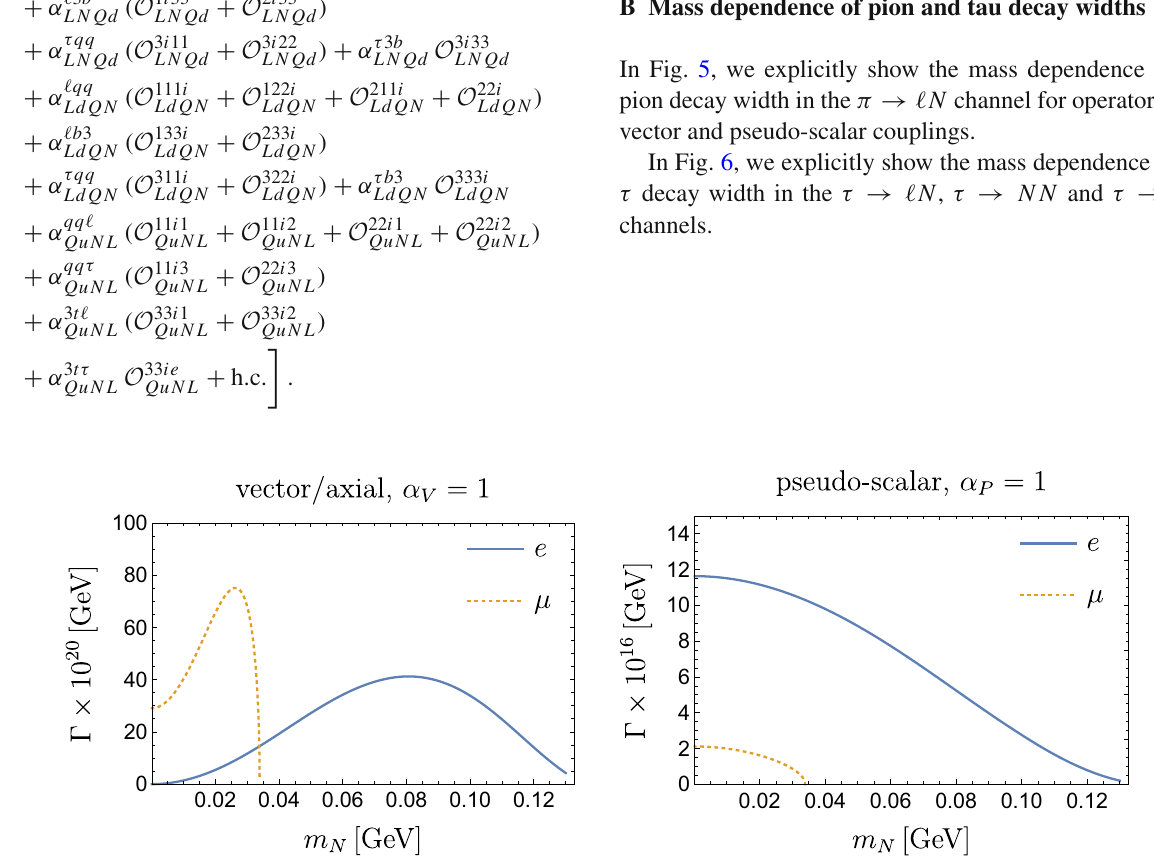
Fig. 5 Dependence of the pion decay width on the neutrino mass m N for operators with axial (left) and pseudo-scalar (right) couplings